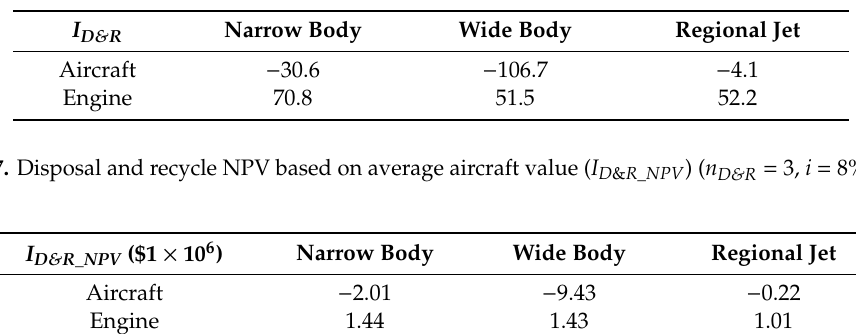
Table 6. Average values of the disposal and recycle economic indicator ( I D & R ).